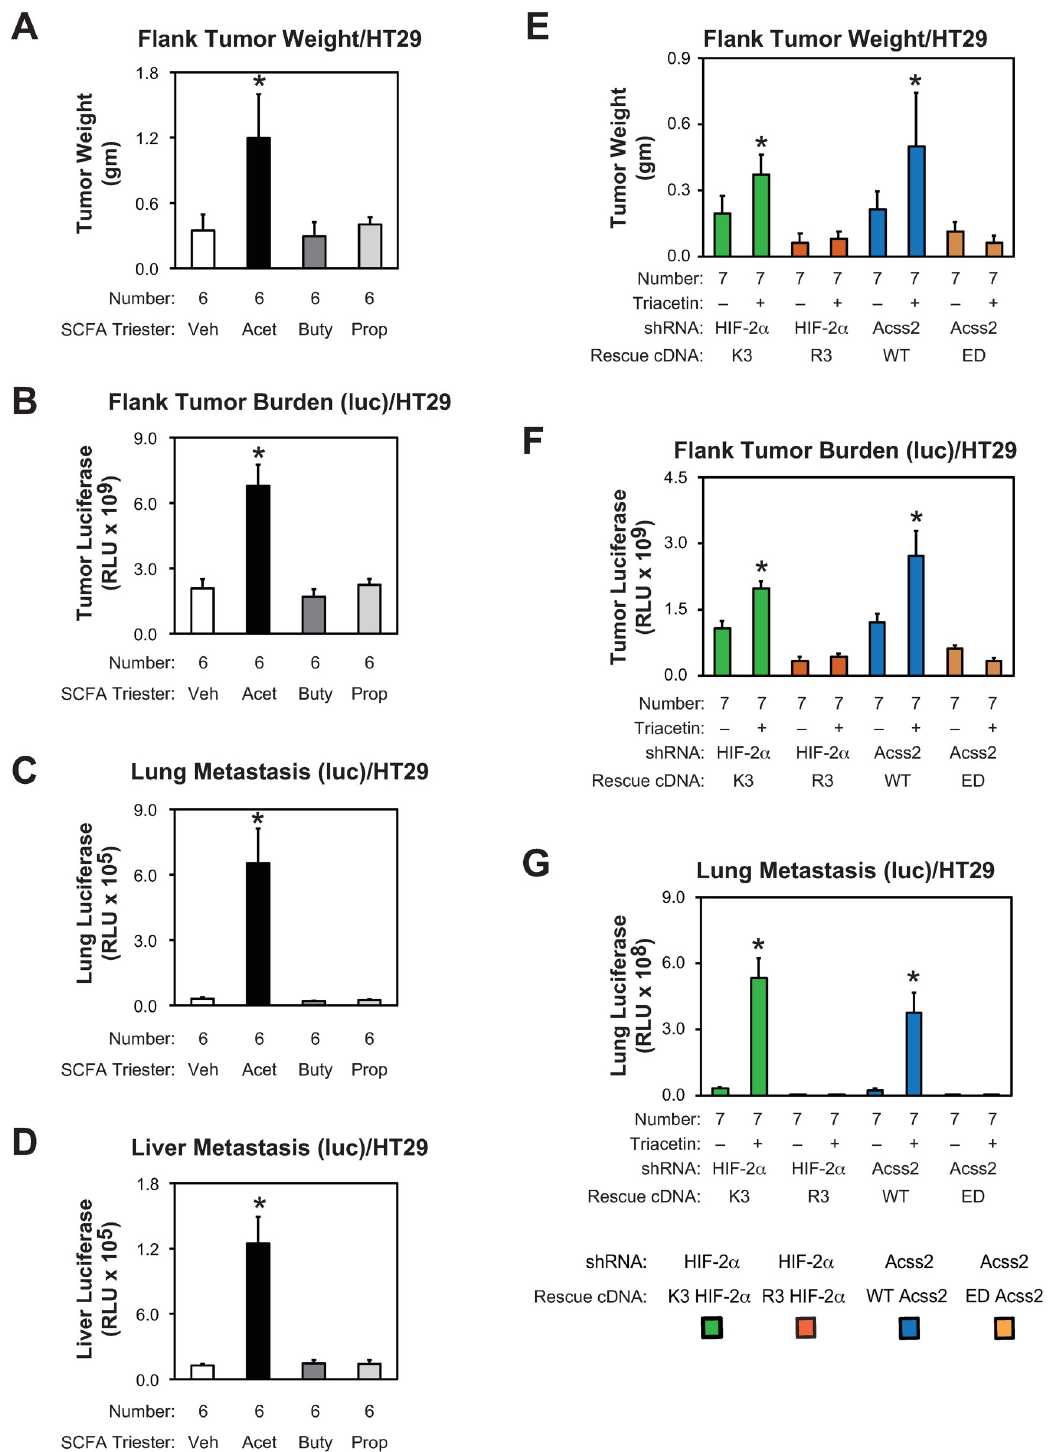
Fig 10. Acetate-augmented HT29 tumor growth requires Acss2/HIF-2 α . (A) Primary tumor weight as well as (B) primary tumor, (C) lung, and (D) liver metastatic burden in nude mice carrying flank tumors derived from luciferase-expressing stably transformed control knockdown HT29 cells treated by oral gavage with control or acetate (Acet; triacetin), butyrate (Buty, tributyrin), or propionate (Prop; tripropionin) tri-ester (n = 6/treatment). (E) Primary tumor weight as well as (F) primary tumor, and (G) lung metastatic burden in nude mice treated by oral gavage with control or acetate carrying flank tumors derived from